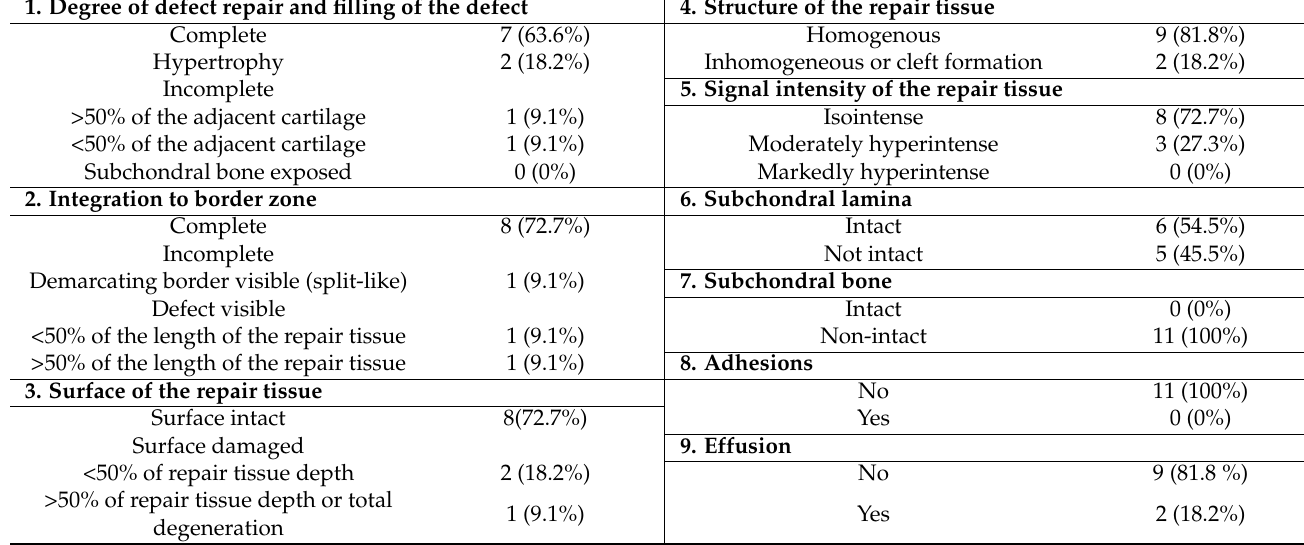
Table 2. MRI assessments of the cartilage repairs one year after the CP